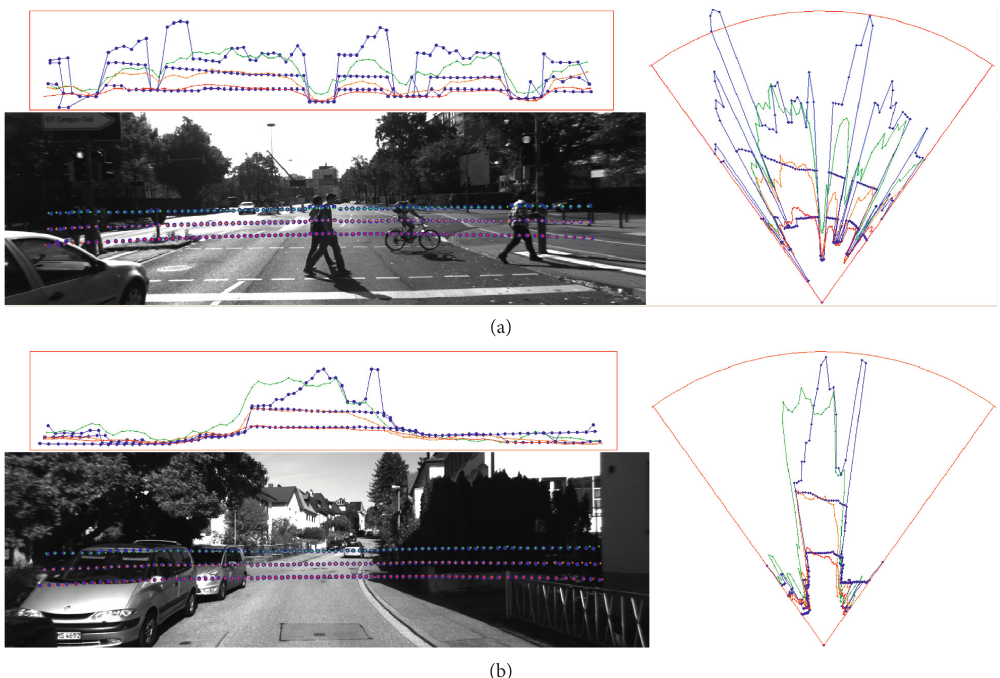
Figure 5: Displaying multilayer prediction for the proposed model (green, orange, and red) on the KITTI testing dataset. Ground truths are in blue. Level 10 is the higher